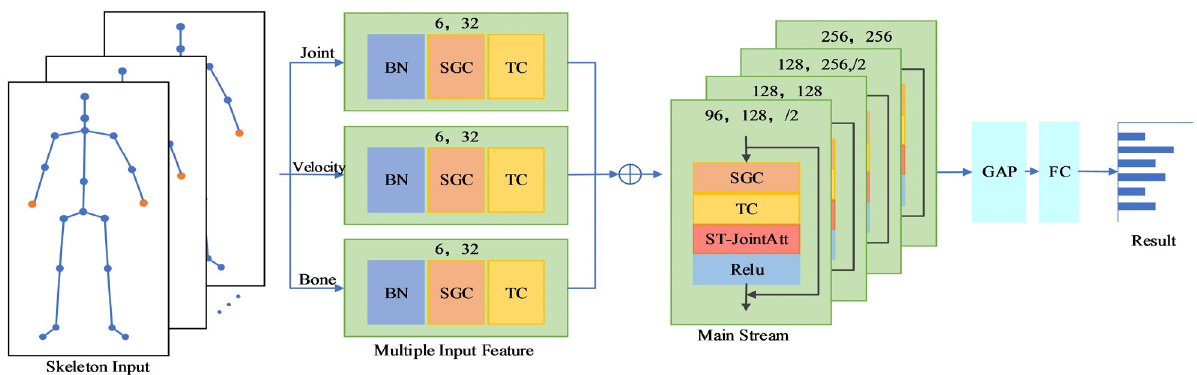
Figure 2. STJA-GCN model structure (The two numbers in each block denote input and output channels, and /2 represents a stride of 2. BN: BatchNorm, SGC: Spatial Graph Convolution, TC: Temporal Convolution, GAP: Global Average Pool, FC: Fully Connected Layer).